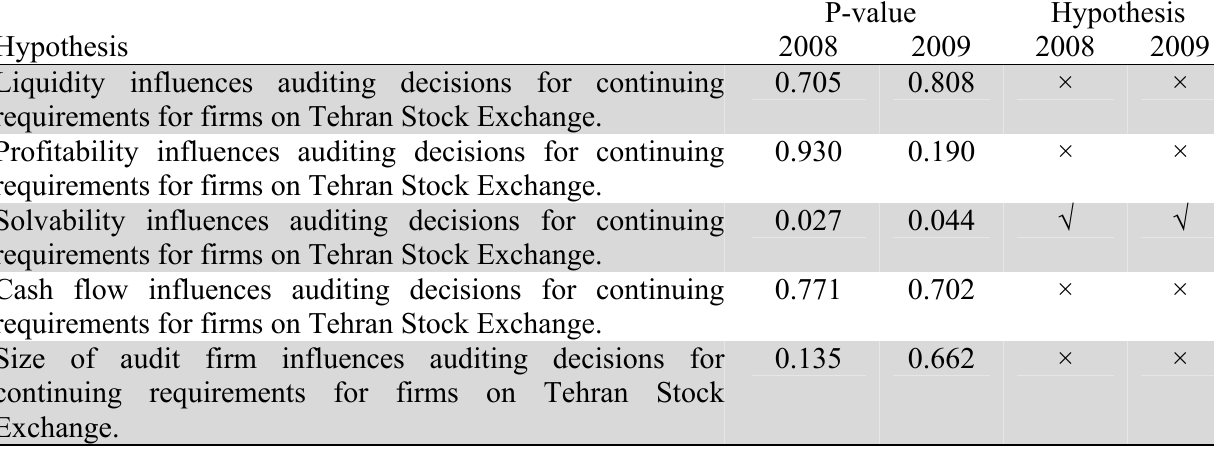
P-value Hypothesis ×